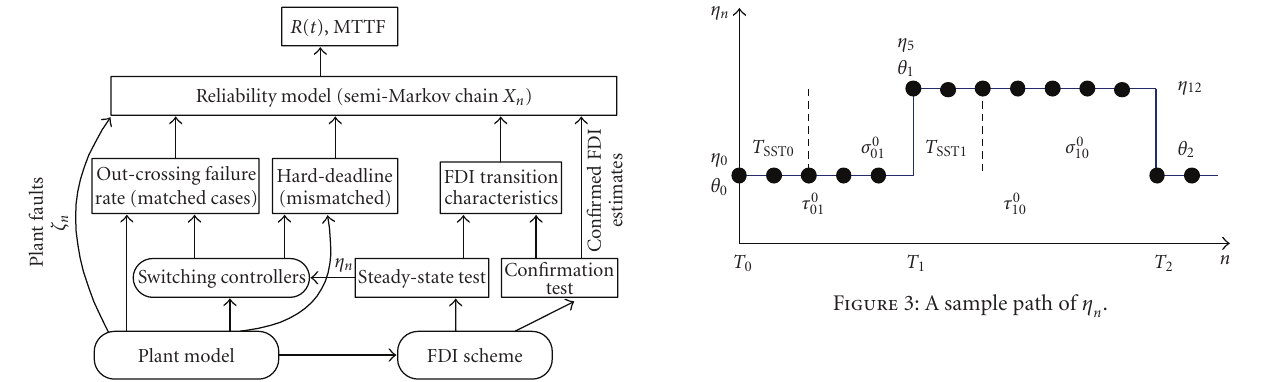
Figure 3: A sample path of η